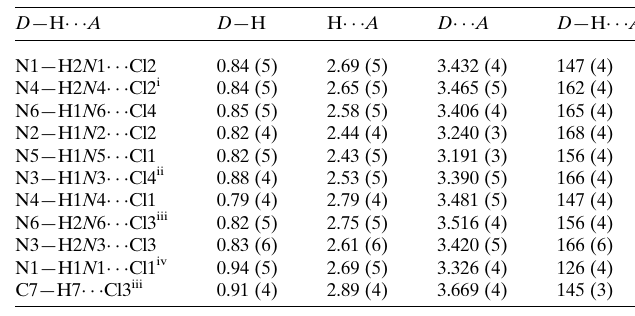
Table 1 Hydrogen-bond geometry (A˚ , (cid:4) ).